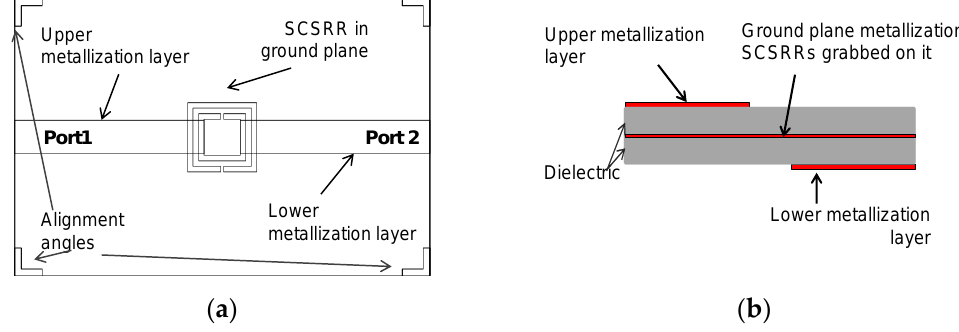
Figure 7. ( a ) Overlapped top view serial 2-layer resonator. ( b ) Schematic front view layer distribution.